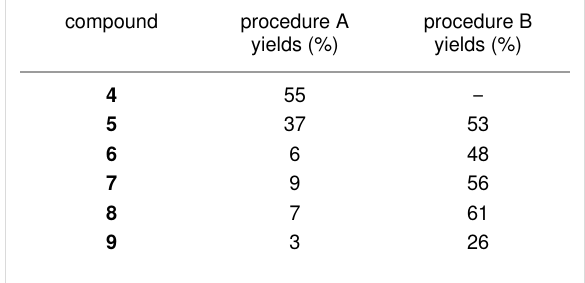
Table 1: AGA of arabinomannosides 4 – 9 . Procedure A modules: i) acidic wash, ii) glycosylation (from − 40 °C to − 20 °C), and iii)